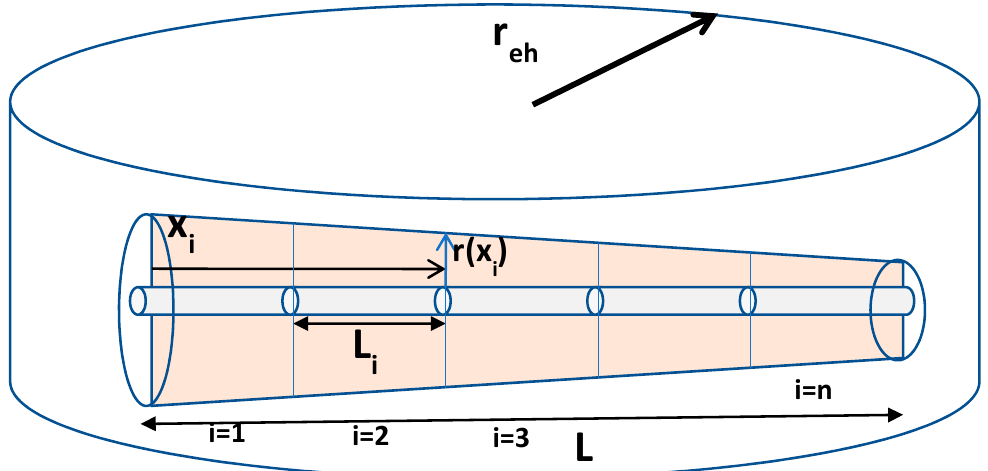
Figure 6. Multi-segment horizontal well Figure 6. Multi ‐ segment horizontal well model.